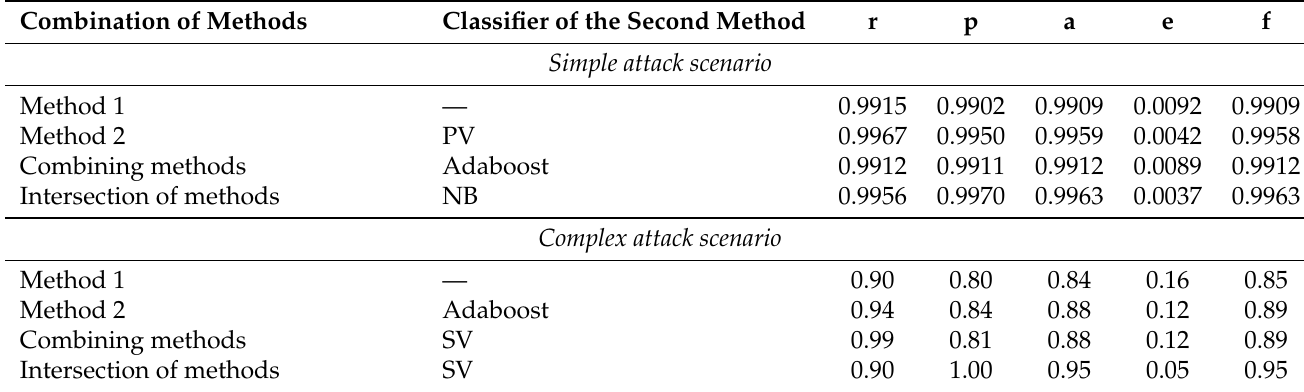
Table 16. Results of testing the complex for detecting insiders